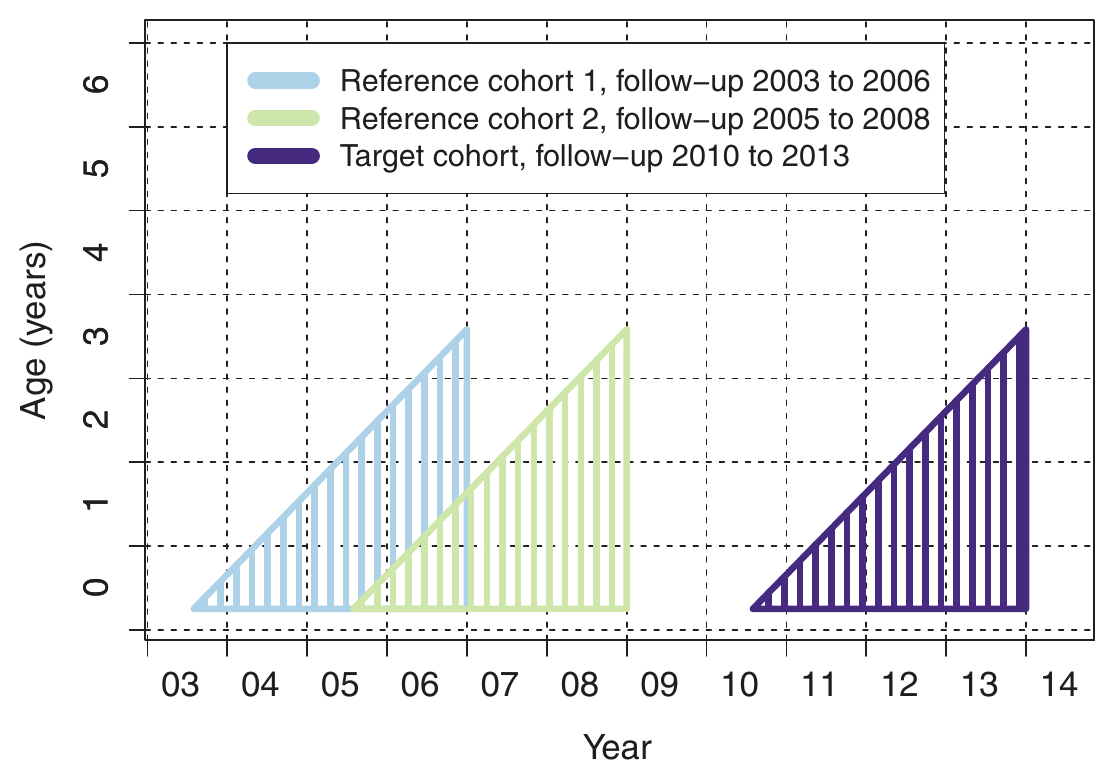
Fig 1. Cohorts for comparing the impact of PCV10 in vaccine-eligible